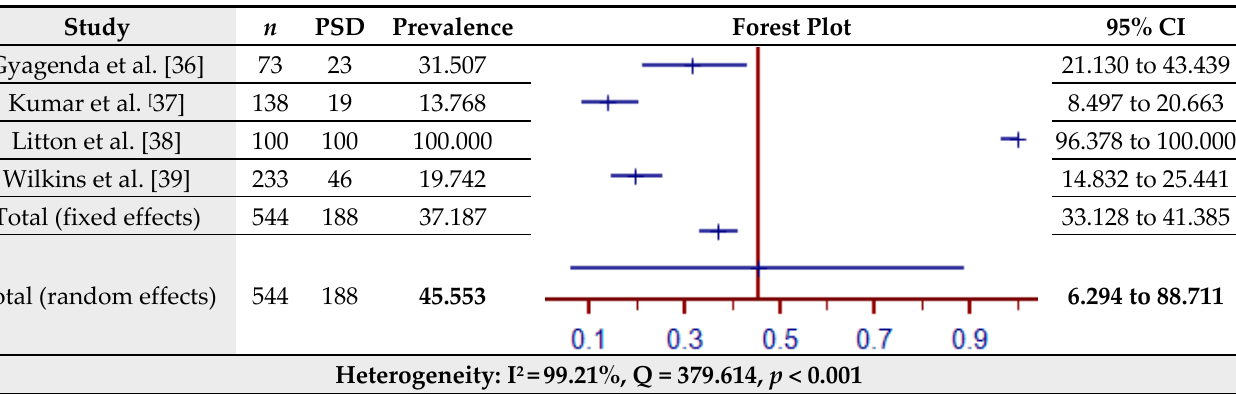
Figure 4. Prevalence estimates of Post-Stroke Depression (PSD) assessed by the Patient Health Questionnaire (PHQ-9).